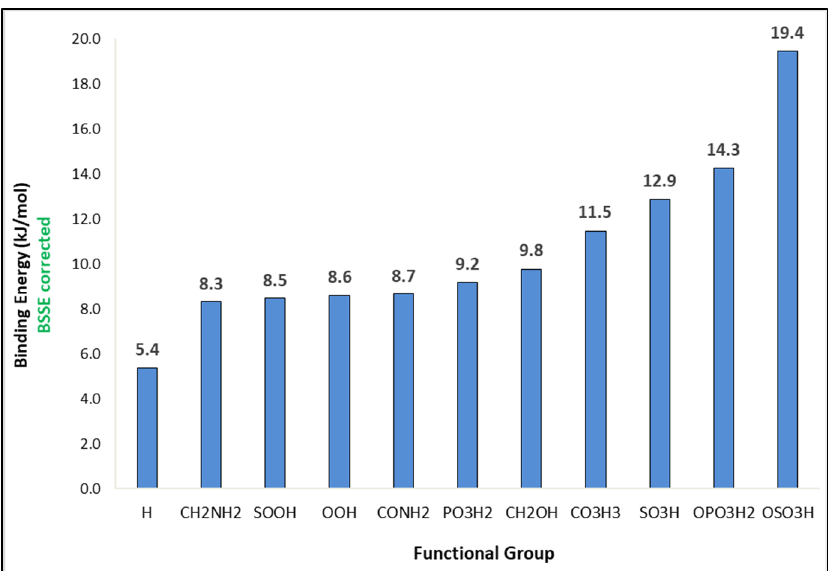
Figure 2. The 10 substituted benzenes with the highest CO binding energy and the unsubstituted benzene for comparison, calculated at the MP2/6-311++G** level of theory and corrected for